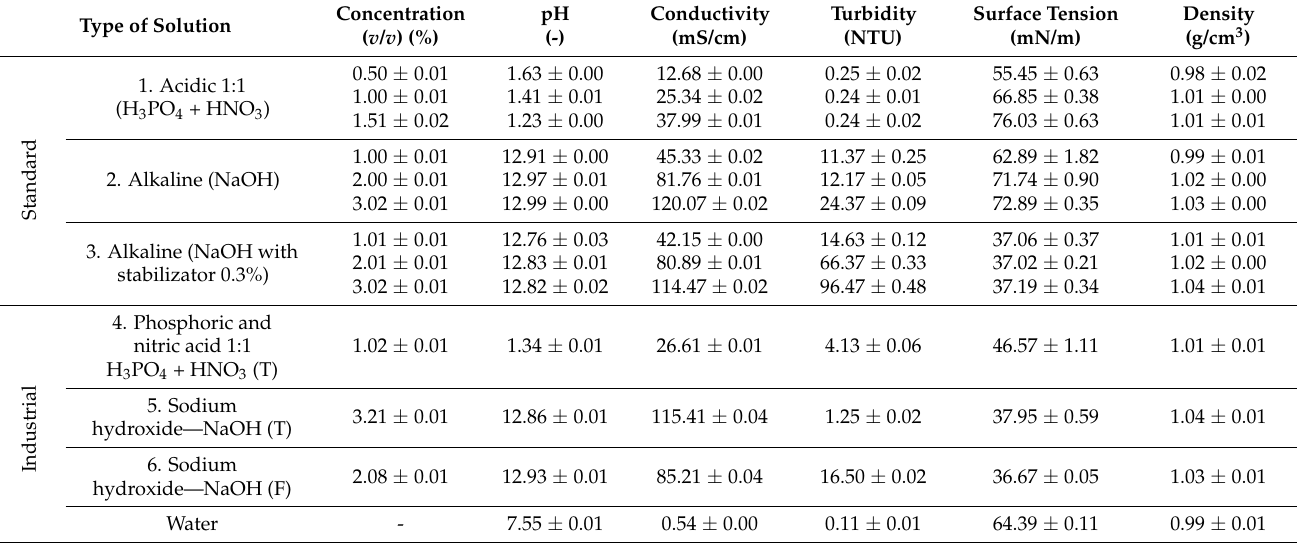
Table 1. Properties of CIP